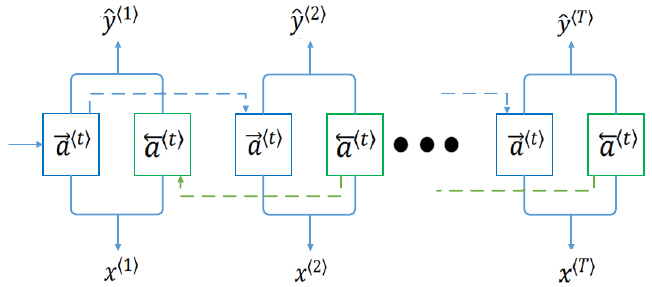
Figure 4. Diagram of the BiLSTM model structure.